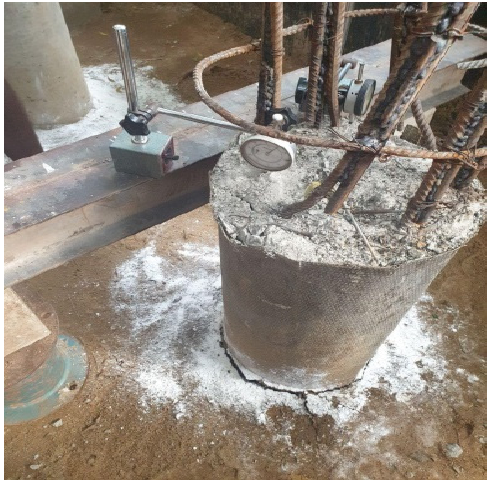
Figure 16. De fl ection of the piles during the uplift.